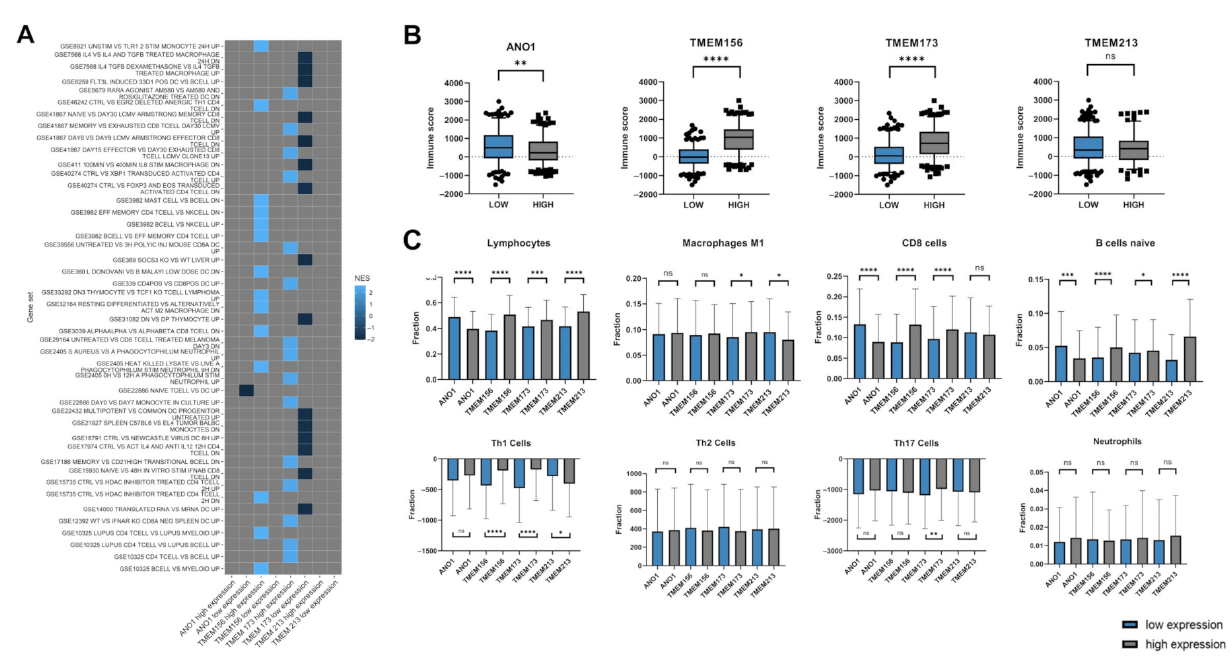
Figure 6. Immunologic profile of HNSCC patients depending on expression levels of ANO1 , TMEM156 , TMEM173, and TMEM213 ; ( A ) phenotype of patients depending on TMEMs levels based on GSEA analysis regarding to immunologic (C7) gene sets with p < 0.05 and FDR < 0.25; gray squares indicate lack of enrichment; ( B ) the level of immune score for low and high expression level of selected TMEM s with the significant p-value. ns : not significant. ( C ) Comparison between low and high expression of TMEMs for lymphocytes, CD8 cells, macrophages M1 and M2, B cells naive, Th1 cells, Th2 cells, Th17 cells and neutrophils with the significant p -value; * p < 0.05; ** p < 0.01; *** p < 0.001; **** p <